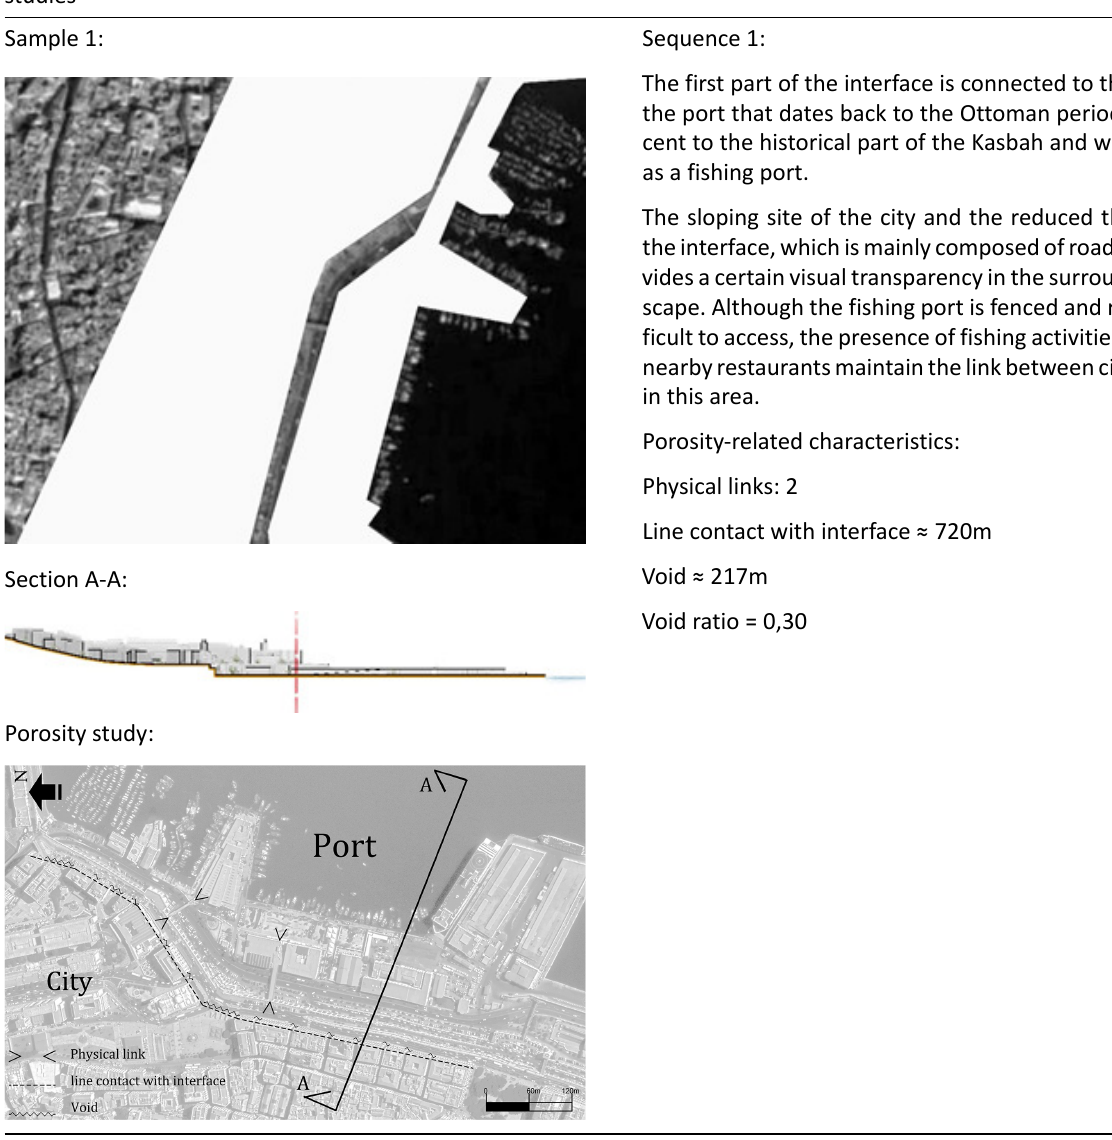
Table 1. Different sequences of Algiers’ current port‐city interface. Satellite views with schematic cross‐sections and